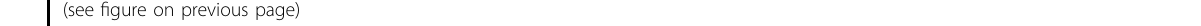
Fig. 1 Expression of circPKNOX1 decreased in degenerative discs. A Heatmap of the circRNA expression matrix of degenerated tissue and control tissue. B Fourteen circRNAs with signi fi cantly reduced expression in degenerative tissue were selected. The expression of hsa_circ_0061853 (circPKNOX1) decreased with the severity of degeneration; * P <0.05, ** P <0.01, *** P <0.001. Data represent mean±SD, and the P values were determined by a two-tailed unpaired Student ’ s t test. C The expression level of circPKNOX1 in human degenerated tissue was lower than that in control tissue; n = 6 different donors; * P <0.05. Data represent mean±SD, and the P values were determined by a two-tailed unpaired Student ’ s t test. D The expression level of PKNOX1 in human degenerated tissue was lower than that in control tissue; n = 6 different donors; *** P <0.001. Data represent mean±SD, and the P values were determined by a two-tailed unpaired Student ’ s t test. E The degenerated and control tissues were analyzed using hematoxylin and eosin staining (top) and magnetic resonance imaging (MRI) (bottom). F Left: circPKNOX1 was labeled with a probe. The fl uorescence intensity in normal tissue was higher than that in degenerated tissue (scale bar, 25 – 100 μ m); n = 2 different donors. Right: circPKNOX1 fl uorescence intensity was quantitatively analyzed; *** P <0.001. Data represent mean±SD, and the P values were determined by a two- tailed unpaired Student ’ s t test. G Left: schematic diagram of circPKNOX1 and probe targeting. Right: the circPKNOX1 probe was labeled with Cy3, and the nucleus was labeled with DAPI. CircPKNOX1 was mainly present in the cytoplasm (scale bar, 100 μ m). H Sanger sequencing con fi rmed th at exons 2 – 9 (red arrow) of PKNOX1 composed circPKNOX1. The black arrow indicates the splice site. I Divergent and convergent primers of circPKNOX1 were designed. In gDNA, divergent primers could not amplify the band. β -actin served as a negative